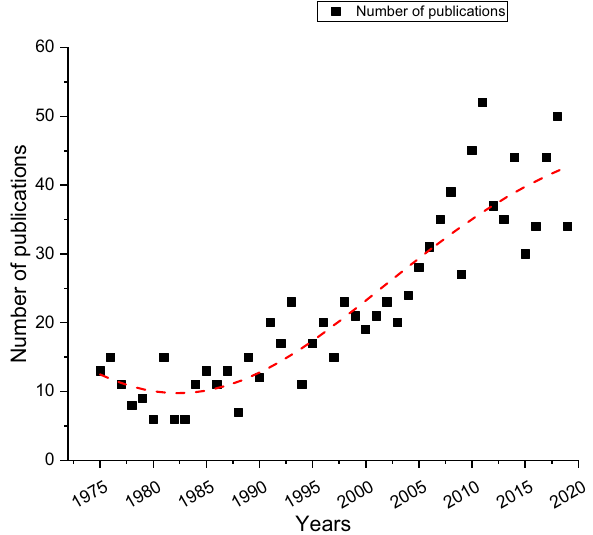
Figure 1: Number of publications overtime. The dashed line is given to ease the